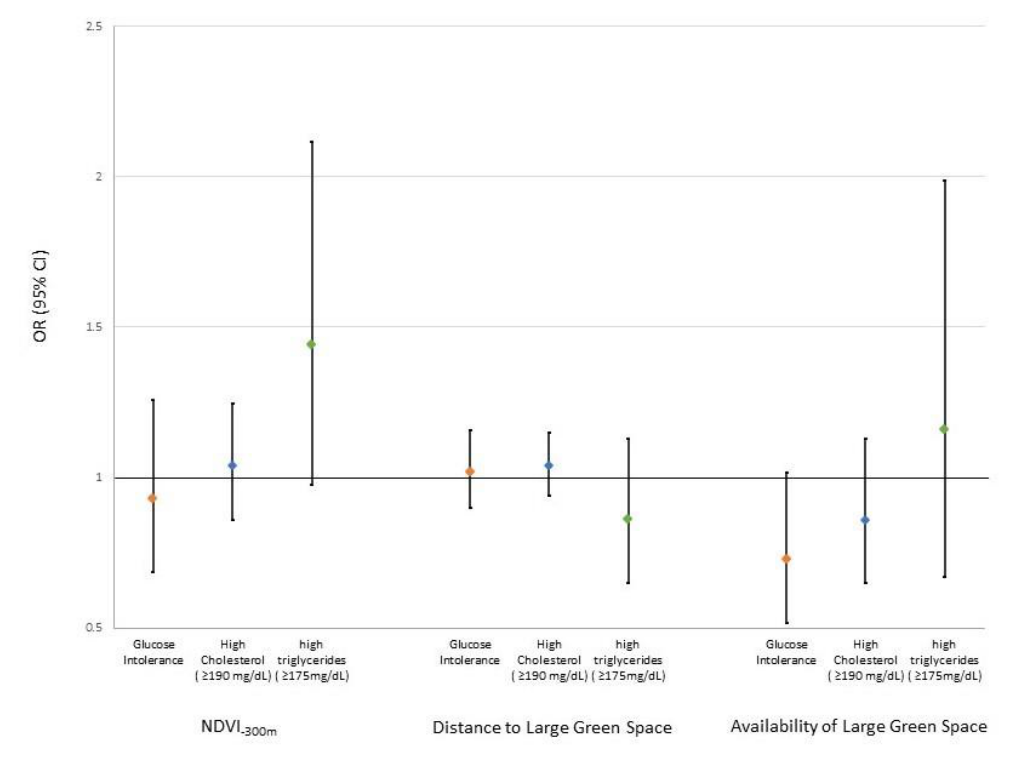
Figure 2. Adjusted odds ratios (OR) and 95% confidence intervals (CI) for the association between increases in residential greenness at 300 m (IQR = 0.19) and distance to (IQR = 162 m) and availability of large green spaces (≥5000 m 2 ) within 300 m of residence in the first trimester and glucose intolerance (IGT and/or GDM) and elevated serum lipids among women of the INMA Cohort, 2003–2008.